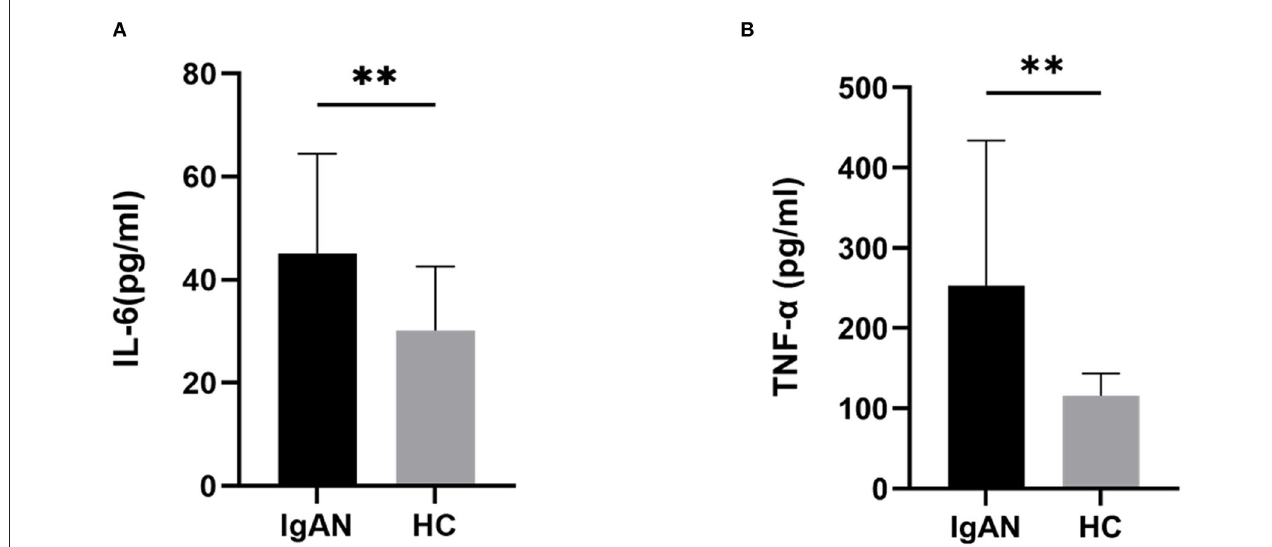
FIGURE 2 | Serum inflammatory cytokine levels in both groups. The serum levels of IL-6, and TNF- α from patients with IgAN were assayed. Higher levels of serum IL-6 (A) , and TNF- α (B) were detected in patients with IgAN compared with healthy subjects. Data are from at least three independent experiments. Data represent the mean ± sd values. * P < 0.05, ** P <